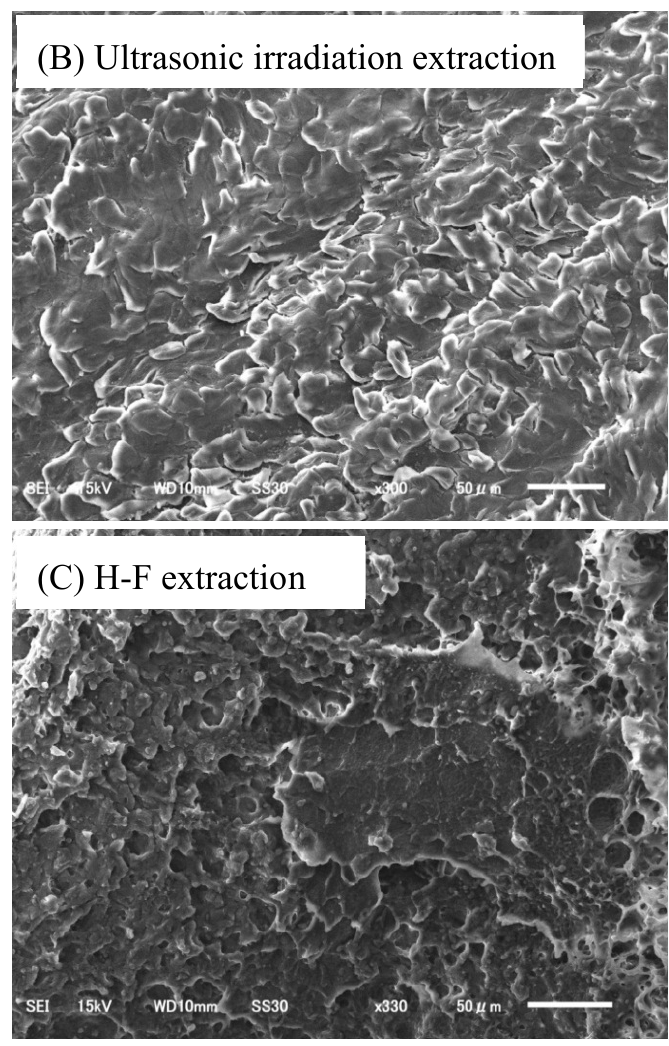
Figure 2. SEM images of the nail surface ( A ) before the extraction treatment, ( B ) after ultrasonic irradiation extraction (30 min), and ( C ) after H-F heating extraction (3 min).